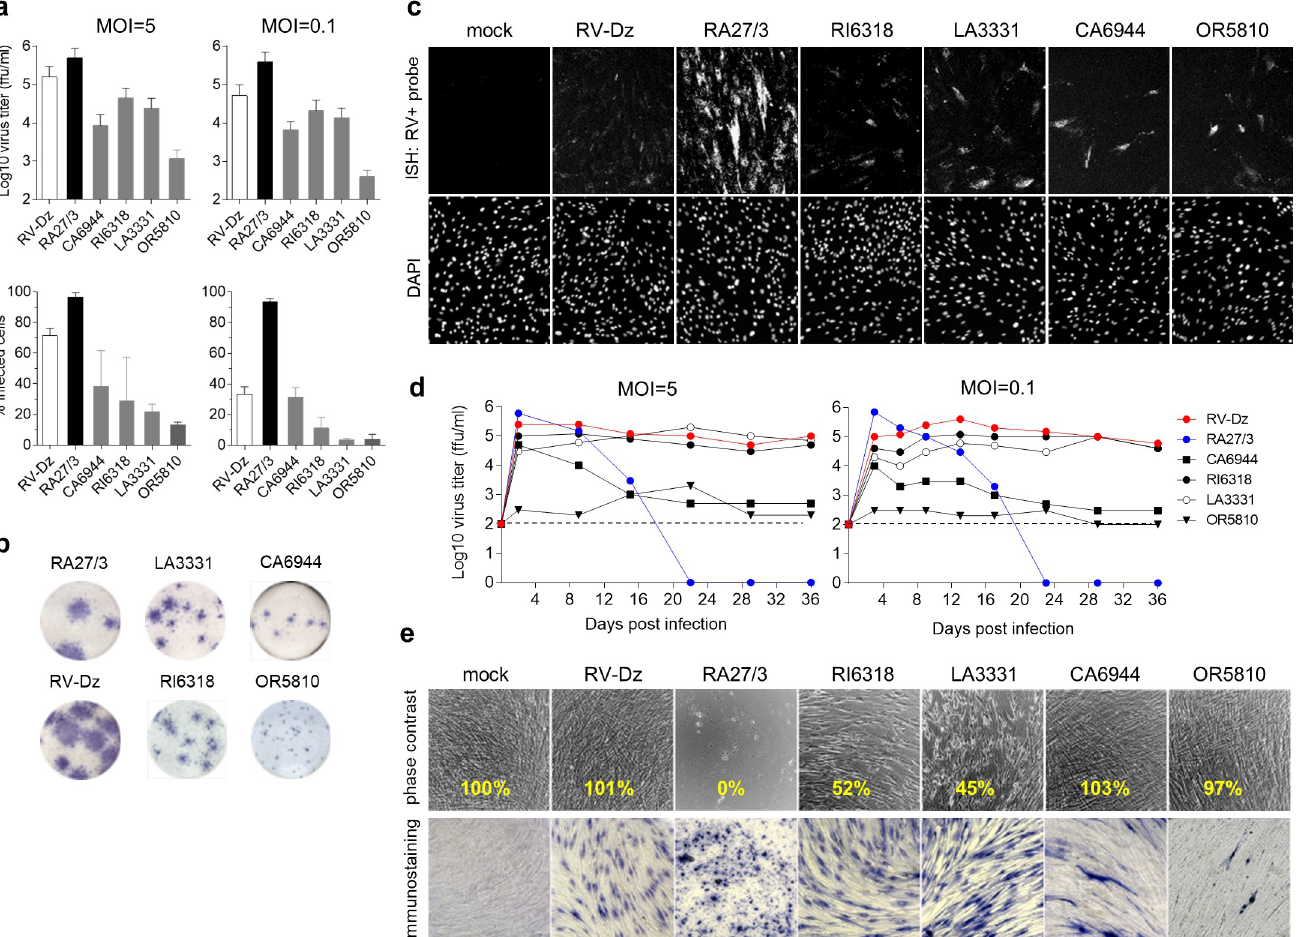
Fig 8. iVDRV growth properties. a. Virus yields and percentages of RV-positive cells after infection of WI-38 with iVDRV, wtRV and RA27/3 strains at MOI = 5 (2 dpi) and MOI = 0.1 (3 dpi). Virus titers in the media were determined by titration on Vero cells, the number of infected cells was estimated by immunostaining for E1 protein. Data are presented as a mean +/- s.d. (n = 3, each experiment was performed in duplicate). b. Foci of infection of iVDRV isolates on Vero cells in comparison to wt and vaccine foci revealed by immunostaining for E1 at 6 dpi. c. Representative images from two independent experiments showing the results of the RNA-FISH for positive-strand RV RNA in WI-38 mock infected or infected with RA27/3 or RV-Dz at MOI = 5 (2 dpi). Nuclei were counterstained with DAPI. d . iVDRV persistence in WI-38. Growth curves of the indicated strains were shown for MOI = 5 and 0.1. Media were collected every 3–6 days and the extracellular viruses were titered on Vero cells. The representative results of two independent experiments each done in duplicate are shown. Limit of the assay detection (1x10 2 ffu/ml) is depicted by the dashed line. e. Phase contrast images of mock infected or infected (MOI = 5) cells at 36 dpi. Note cytopathic effects of RI6318 and LA3331 and the lack of live cells in RA27/3-infected wells. The adherent cells from one of two duplicate wells at 36 dpi were counted; the percentage of remaining adherent cells in each well was calculated relative to the mock infected well (yellow text). The cells in the second duplicate well were immunostained for E1.